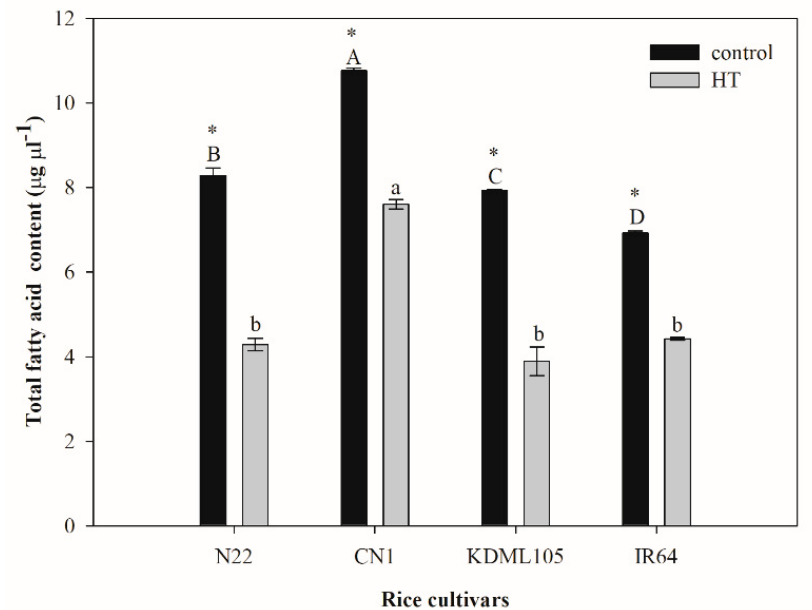
Figure 3. Effect of HT on total fatty acids in four rice cultivars (N22, CN1, KDML105 and IR64). Each